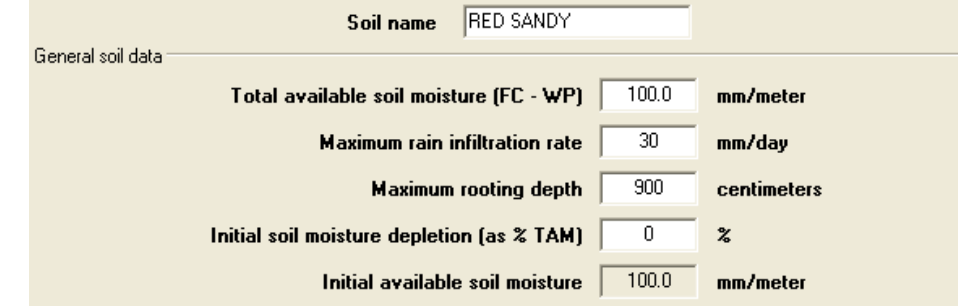
Figure 2. Soil information belonging to area.